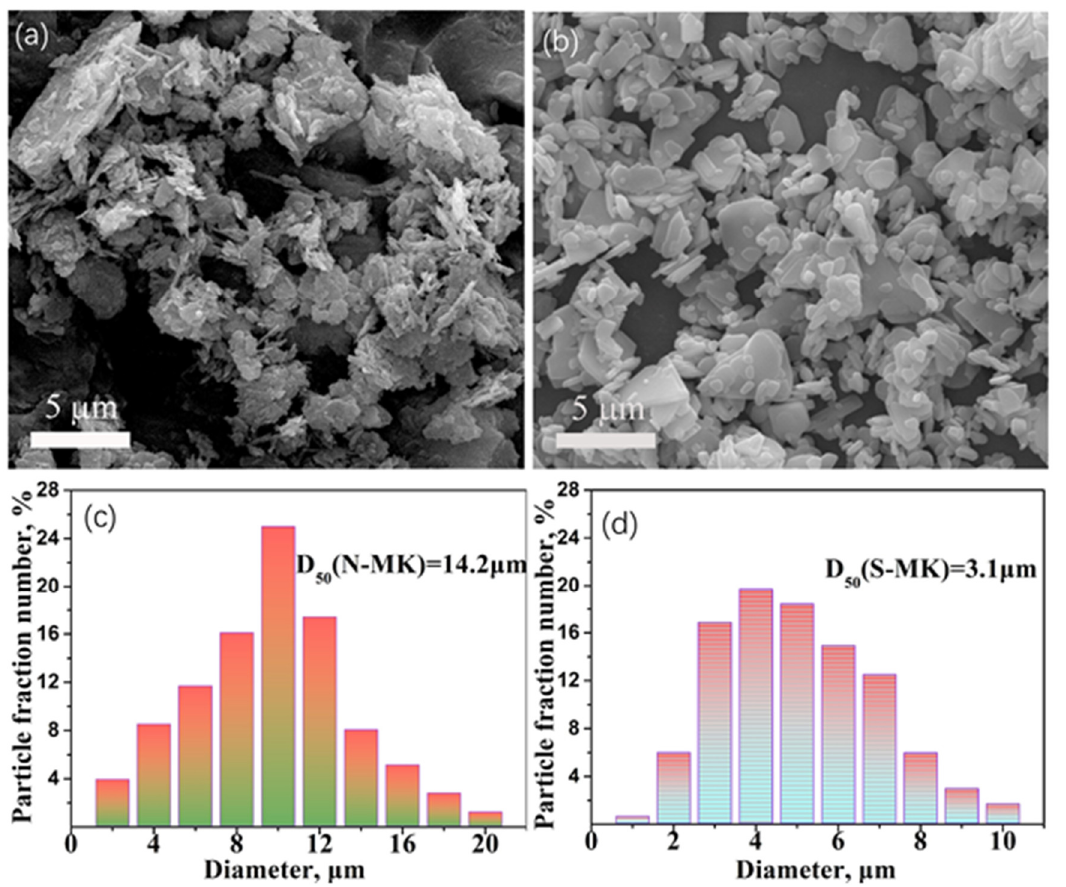
Figure 4. SEM images and particle distributions of ( a , c ) natural metakaolin (N-MK) and ( b , d ) synthetic metakaolin (S-MK).